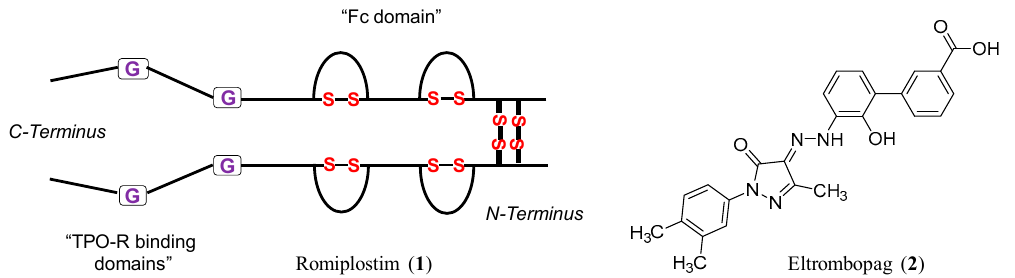
Figure 1. Structuralrepresentationsofromiplostim( 1 )andeltrombopag( 2 ). Therepresentationofromiplostim shows the TPO-R binding domain at the C-terminus and the Fc domain at the N-terminus. Glycine bridges linkthetwodomains. Inter-andintra-disulfidebondsarealsoshown. Thestructureofeltrombopagshowsthe biphenyl carboxylic acid domain “right-hand domain” and the dimethylphenyl domain “left-hand domain” both of which are linked together by dihydro-pyrazol-4-ylidene-hydrazino